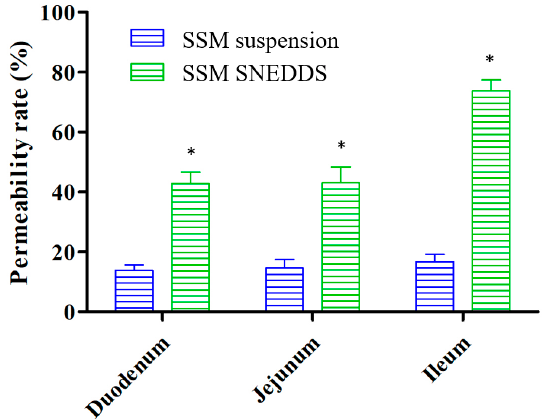
Figure 5. Permeability evaluation of SSM suspension and SSM–SNEDDS in different small intestine segments. Different small intestine segments were incubated in Tyrode’s solution containing SSM suspension or SSM–SNEDDS at 37 ± 0.5 °C for 1 h. Results are expressed as the mean ± standard deviation of the mean ( n = 6 for each group). * p < 0.001, compared with the group of SSM suspension.